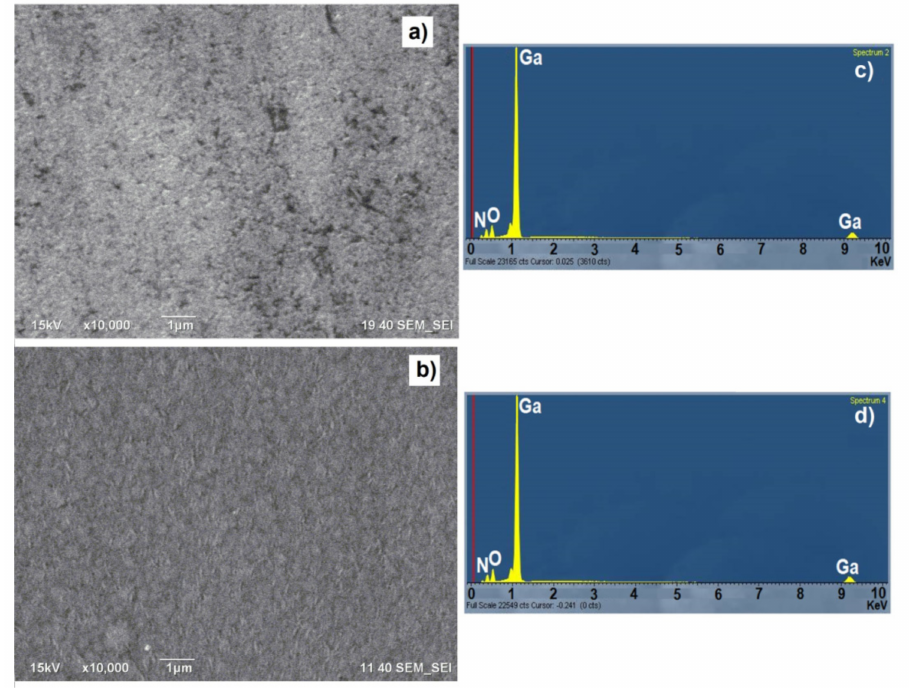
Figure 3. ( a – c ) SEM-EDS micrographs for the Zn-doped GaN films; ( b – d ) SEM-EDS micrographs for the Mg-doped GaN